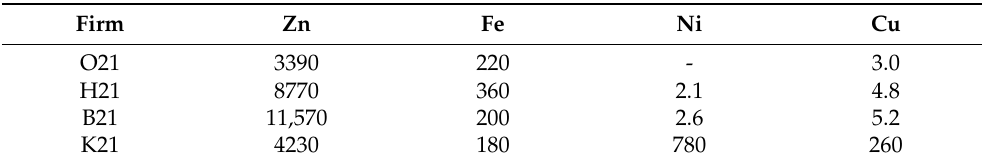
Table 7. Zn and Fe contents in the leach (filtrate) after leaching and subsequent precipitation using ammonia (mg/L).